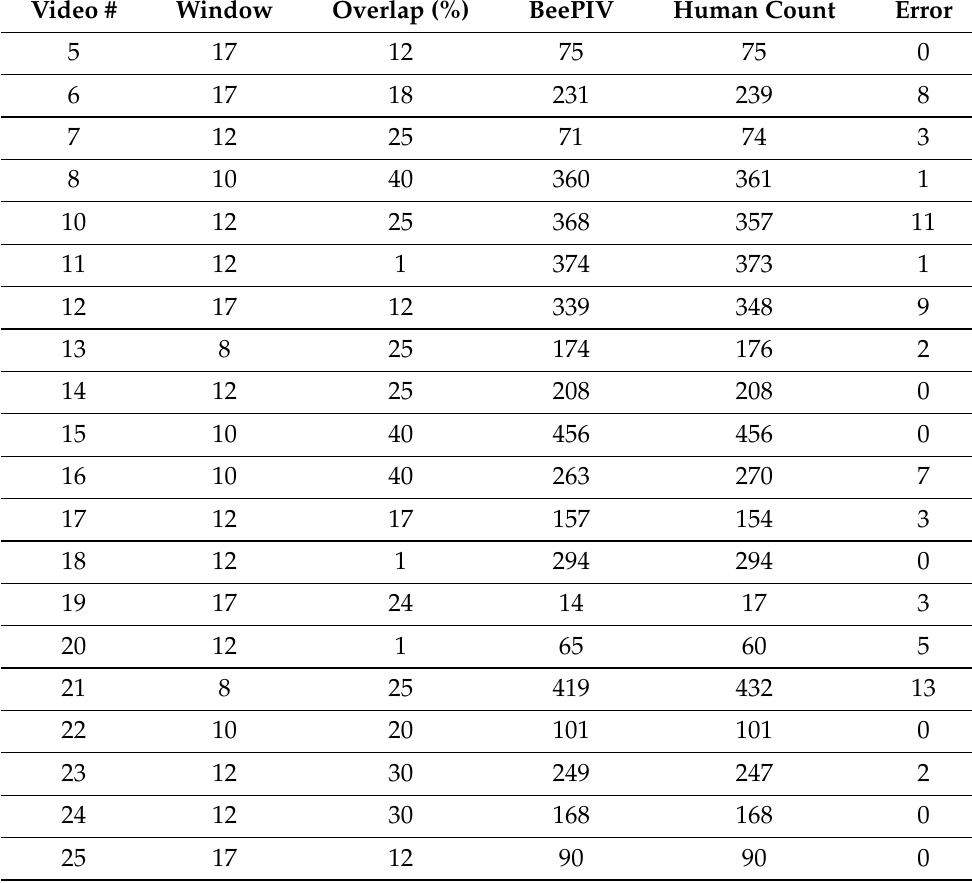
Table 1. Interrogation window size and overlap for each video in testbed that resulted in smallest absolute error between BeePIV and human counts for that video; values in BeePIV column are I ∗ w ( Z ) + O ∗ w ( Z ) + L ∗ w ( Z ) , where Z is motion frame sequence of corresponding video V ; values in Err column are absolute differences between corresponding values in Human Count and BeePIV